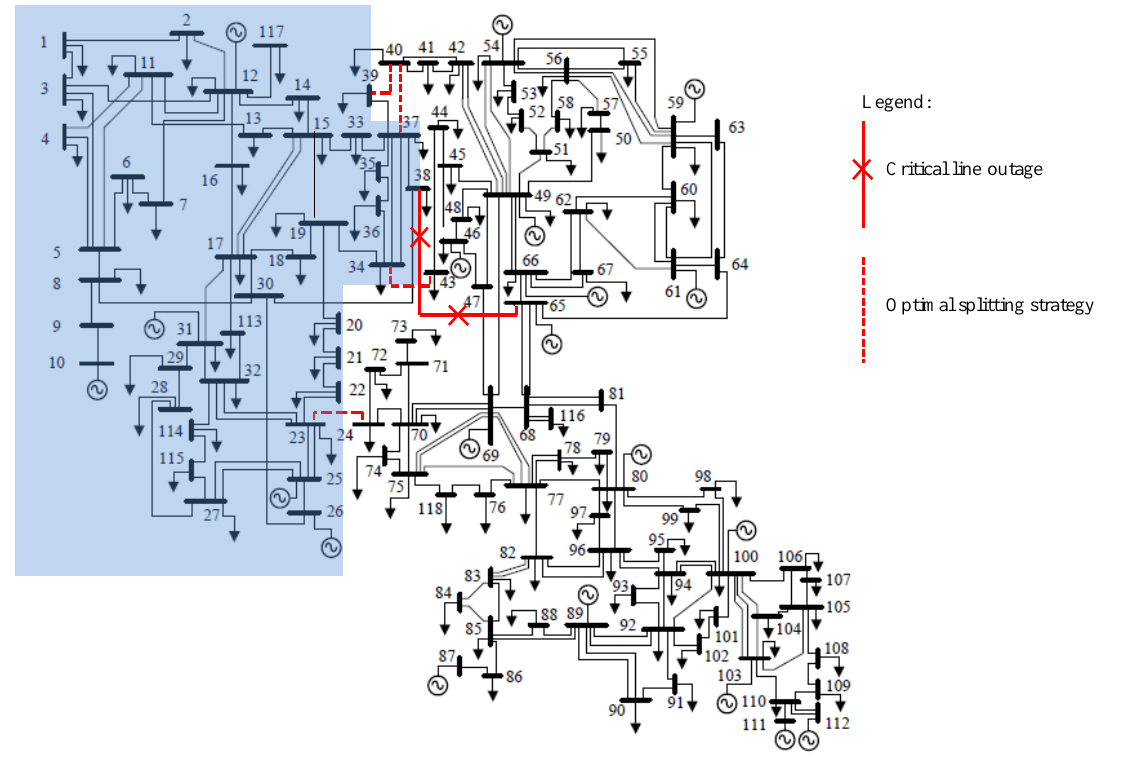
Figure 8. Optimal network splitting solution (dashed red lines) for the IEEE 118 bus system—Case B.